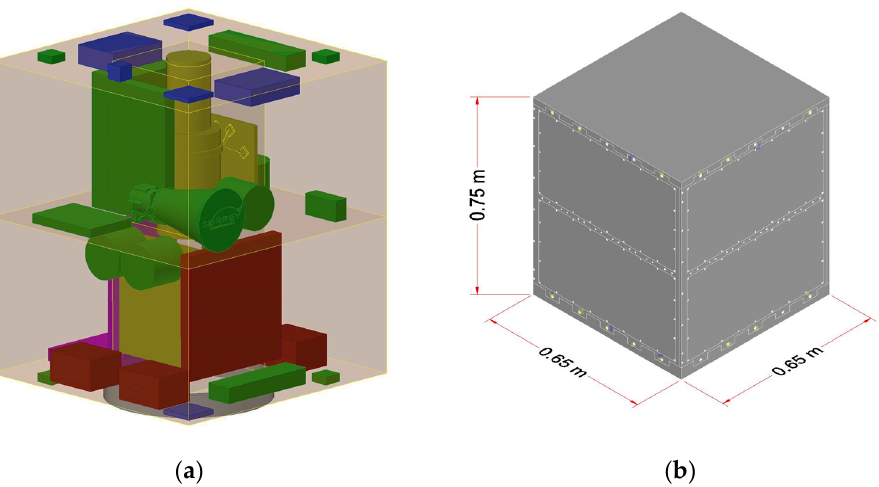
Figure 1. ( a ) Microsatellite subsystem configuration concept. ( b ) General outer view and outer di- mensions of the microsatellite. dimensions of the